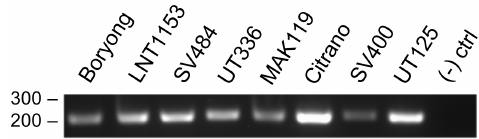
Figure 6. Primer set ompA -57F/260R amplifies ompA sequences having one to three nucleotide mismatches in the primer binding sites. DNA isolated from tissue culture cells infected with each of the indicated O. tsutsugamushi isolates or minus template control (( − ) ctrl) were subjected to PCR analysis using ompA -57F/260R primers. The numbers to the left of the panel correspond to DNA ladder sizes. Data are representative of three experiments with similar results.